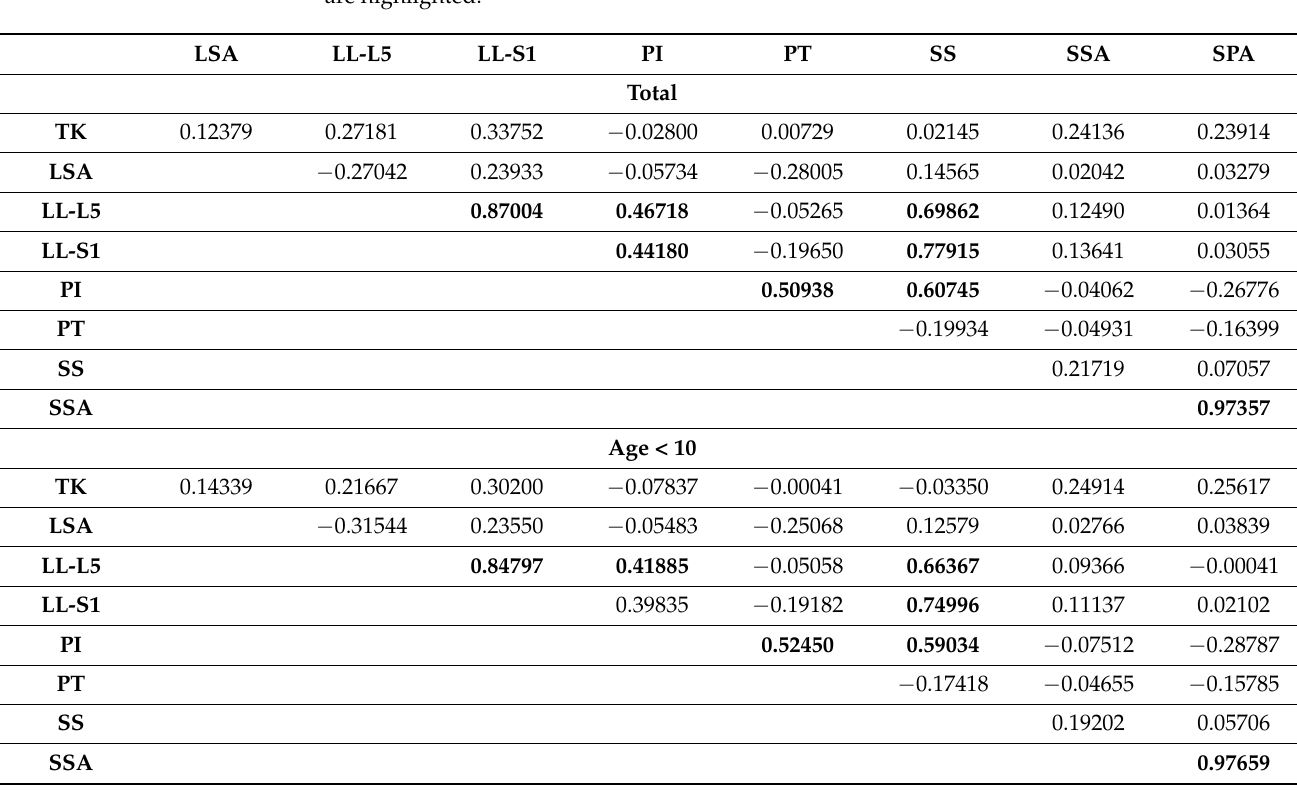
Table 2. Correlation coefficients for pelvic and spinal sagittal balance in the total population and in the oldest (age 15–18) and youngest (age < 10) groups. Pearson’s coefficients higher than 0.4 are